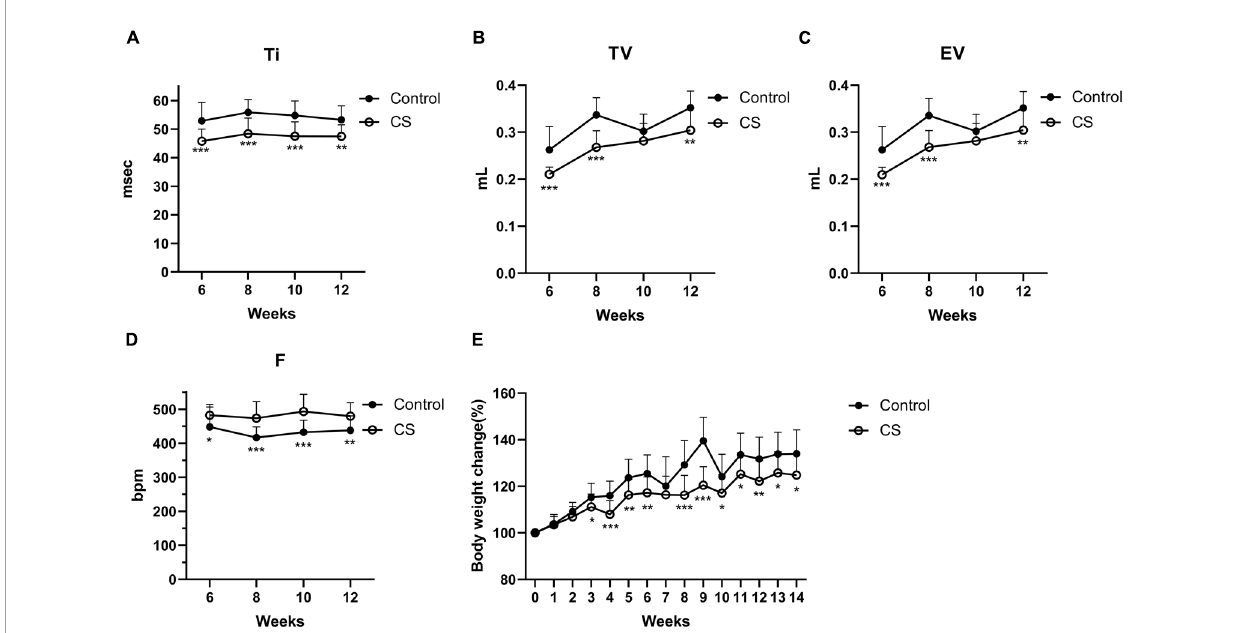
FIGURE2 Lung function and body weight changes in conscious mice during CS exposure. Inspiratory time (Ti) (A) , tidal volume (TV) (B) , expiratory volume (EV) (C) , frequency (F) (D) , and body weight changes (E) in control ( n = 21) and CS-exposed ( n = 16) group. Data was expressed as means ± SD. * p < 0.05, ** p < 0.01, and *** p < 0.001, compared with air exposure group.